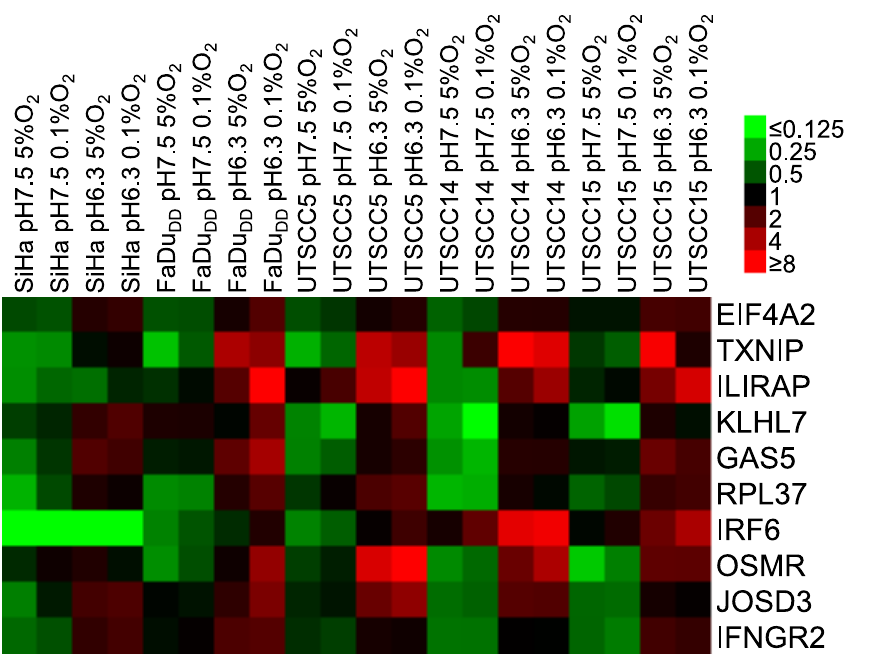
Fig 2. pH induced genes across cell lines. Expression (microarray data) of genes found to be more than 2 fold upregulated under low pH independent of hypoxia in 4 out of 5 cell lines (SiHa, FaDu DD , UTSCC5, UTSCC14 and UTSCC15). Data displayed is log transformed and median